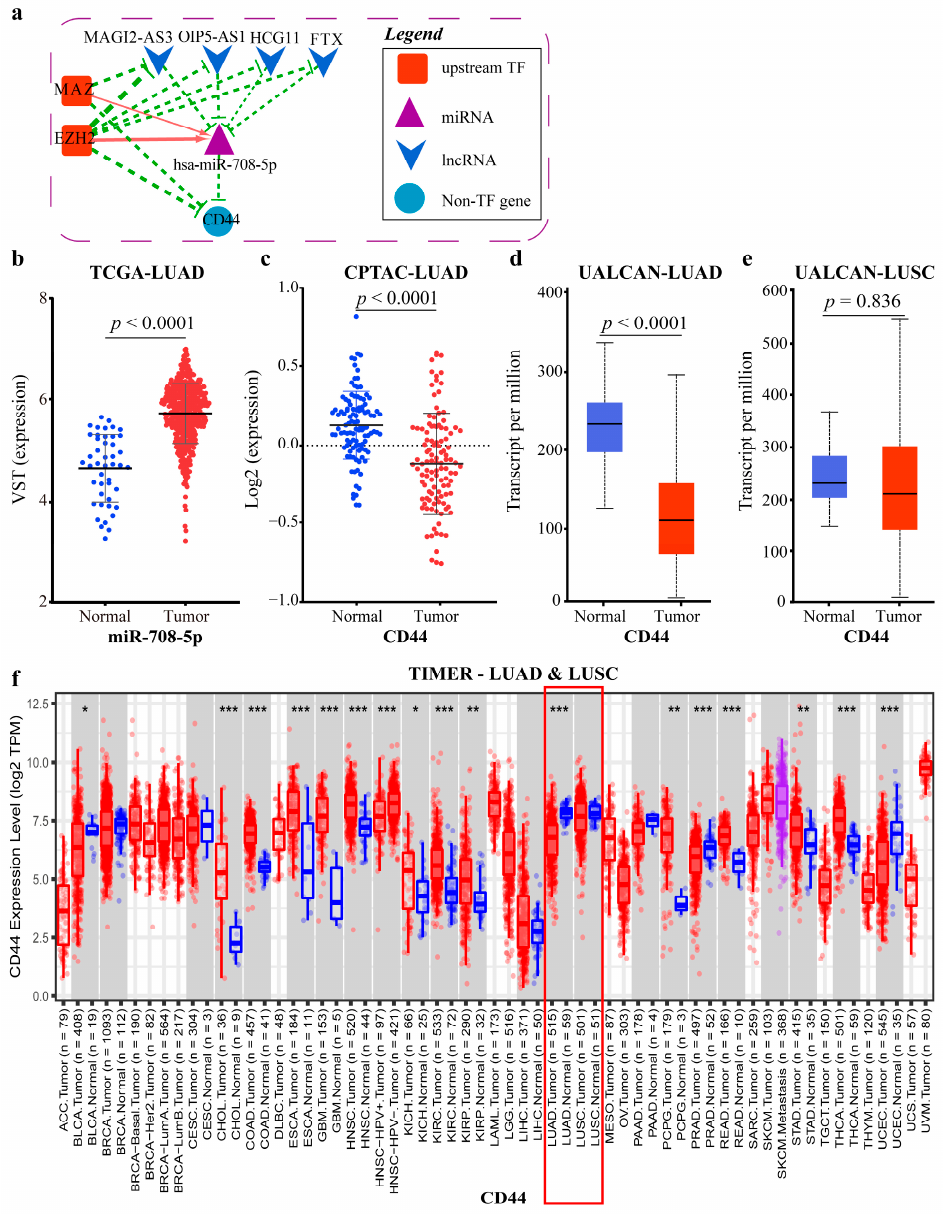
Figure 12. MiR-708-5p related ceRNA-hub-FFL subnetwork and target genes: ( a ) MiR-708-5p related ceRNA-hub-FFL subnetwork (only I-FFL). Green dashed line indicates inhibition, while red indicates activation, and line thickness indicates the strength of correlation; ( b ) MiR-708-5p expression data of LUAD in TCGA; ( c ) CD44 proteome data of LUAD in CPTAC; ( d ) CD44 mRNA expression data of LUAD in UALCAN; ( e ) CD44 mRNA expression data of LUSC in UALCAN; ( f ) CD44 mRNA expression data of LUAD and LUSC in TIMER. The blue dots/boxs indicate the normal samples, while the red dots/boxs indicate the tumor samples. *: p < 0.05; **: p < 0.01; ***: p < 0.001.